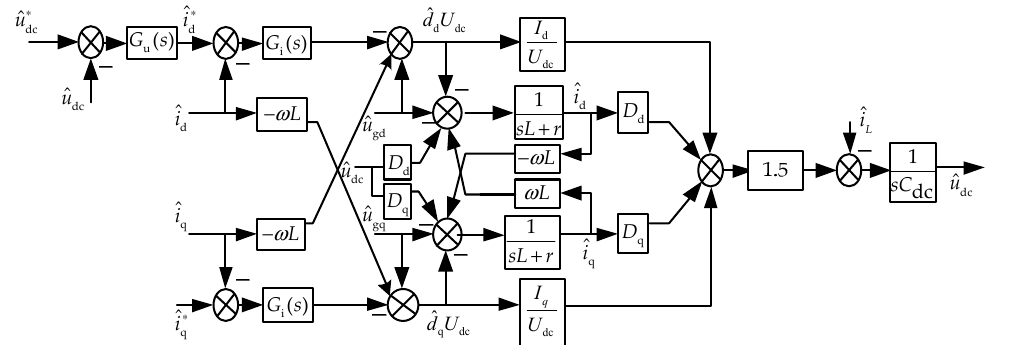
Figure 5. Three-phase PWM rectifier small signal control block diagram.